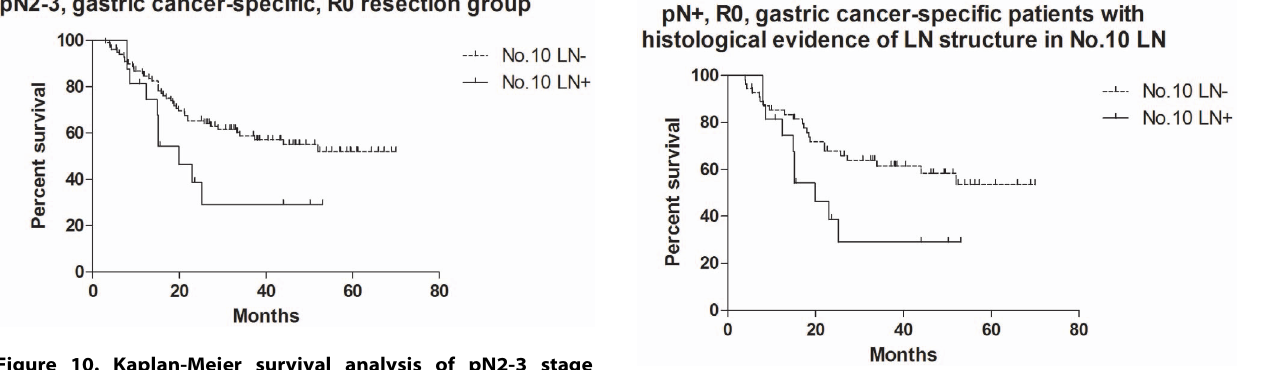
Figure 12. Kaplan-Meier survival analysis of pN + stage gastric cancer specific + R0 resection group in patients with histolog-